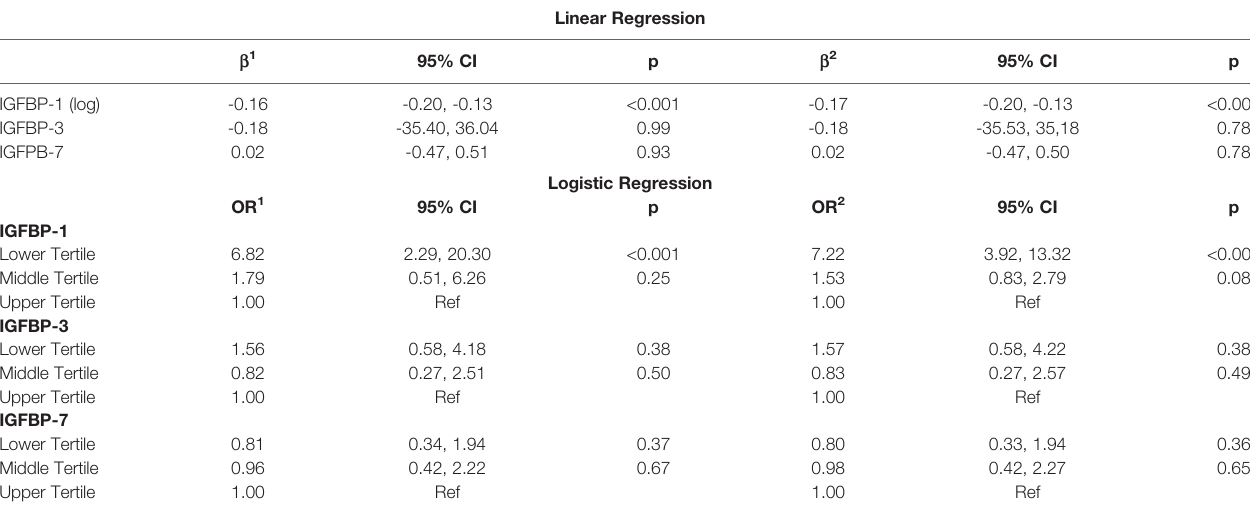
TABLE 2 | Association between IGFBPs and weight status in adolescents.